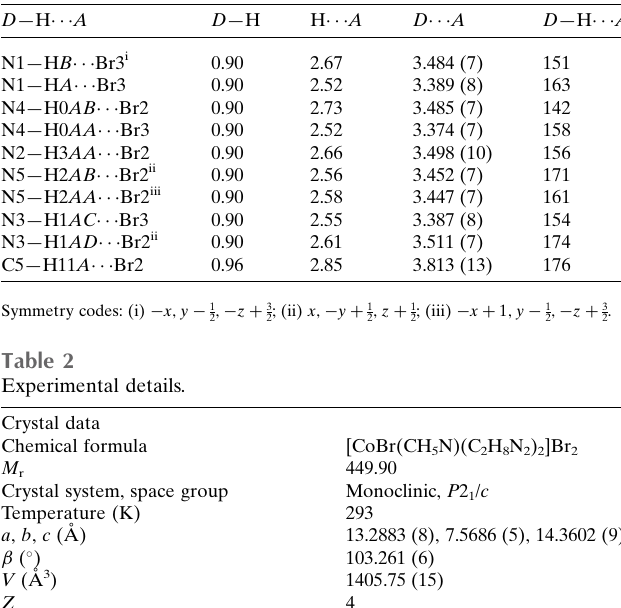
Table 1 Hydrogen-bond geometry (A˚ , (cid:5) ).